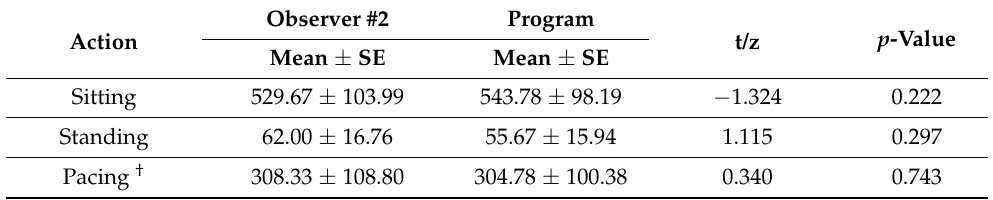
Table 3. Comparison of the measurement analysis between the automated program and the observer #2.